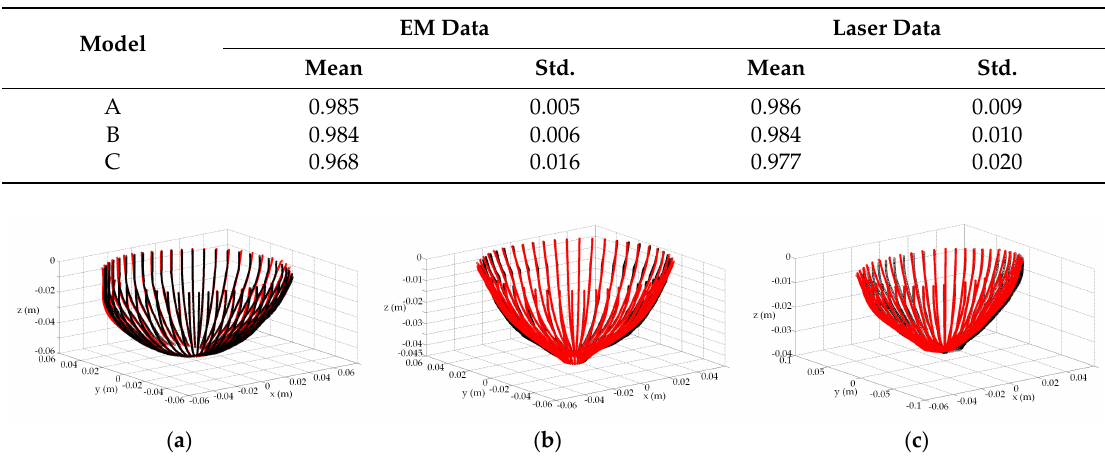
Figure 13. Contours of surface model are uniformly sampled to form a cloud of points (red dots andblack dots) corresponding to the estimated surface from the electromagnetic and laser data, respectively. Surface estimates of models ( a ) A, ( b ) B, and ( c ) C.